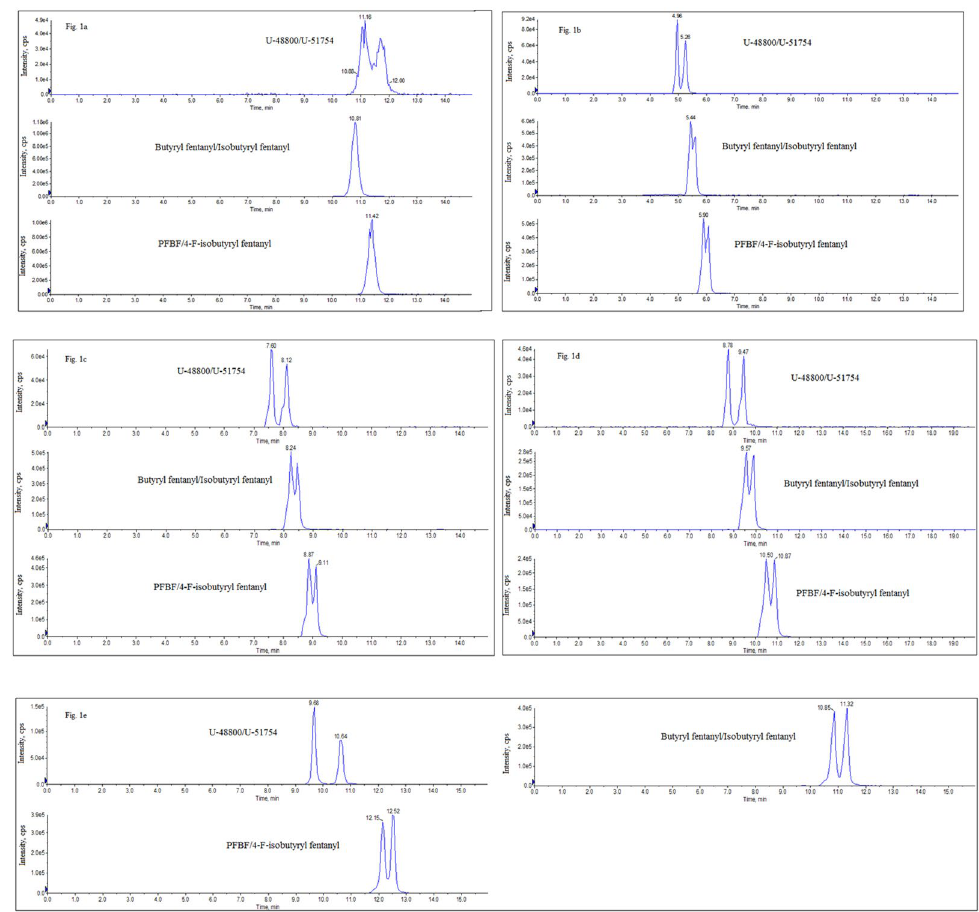
Figure 1. Chromatograms under different liquid conditions. ( a ) Different columns-WATERS T 3 column; ( b ) different organic mobile phase-acetonitrile; ( c ) extending analysis time; ( d ) modifying the gradient elution; ( e ) reducing the flow